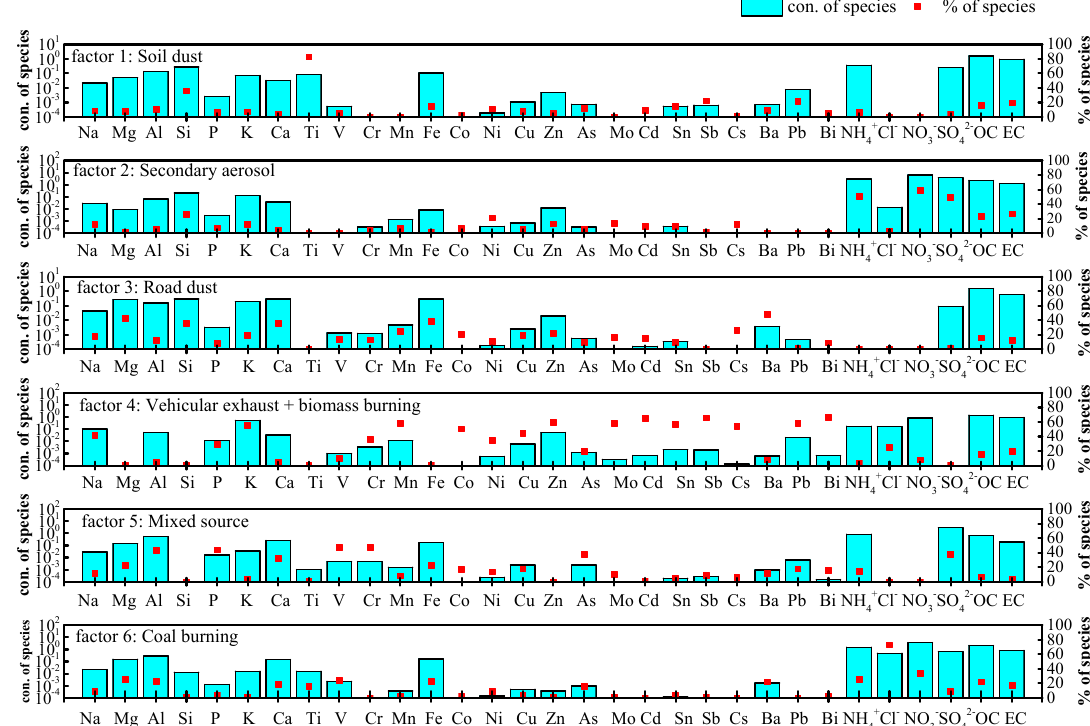
Figure 6. The results of the source profile of six factors identified by positive matrix factorization (PMF).